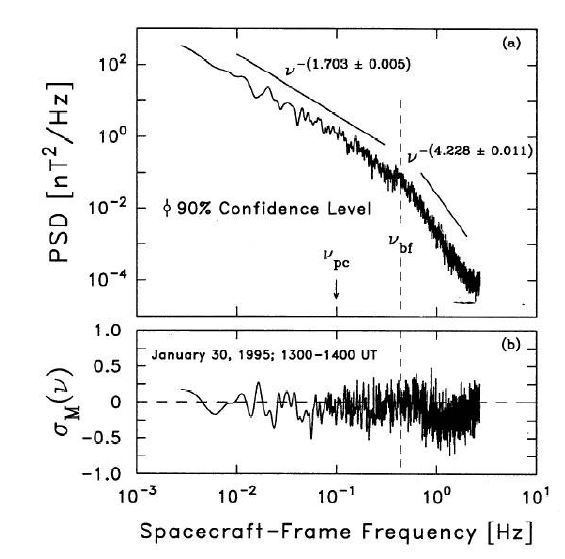
Figure 110: a) Typical interplanetary magnetic field power spectrum obtained from the trace of the spectral matrix. A spectral break at about ∼ 0.4 Hz is clearly visible. b) Corresponding magnetic helicity spectrum. Image reproduced by permission from Leamon et al. (1998), copyright by